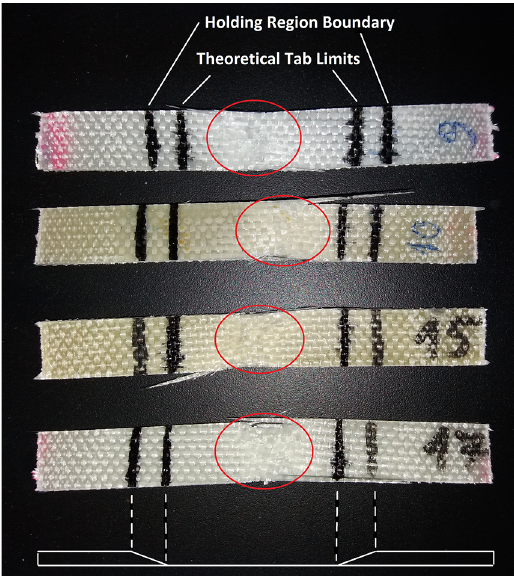
Figure 3. Holding region boundaries and theoretical tab limits for the composite laminates which underwent tensile